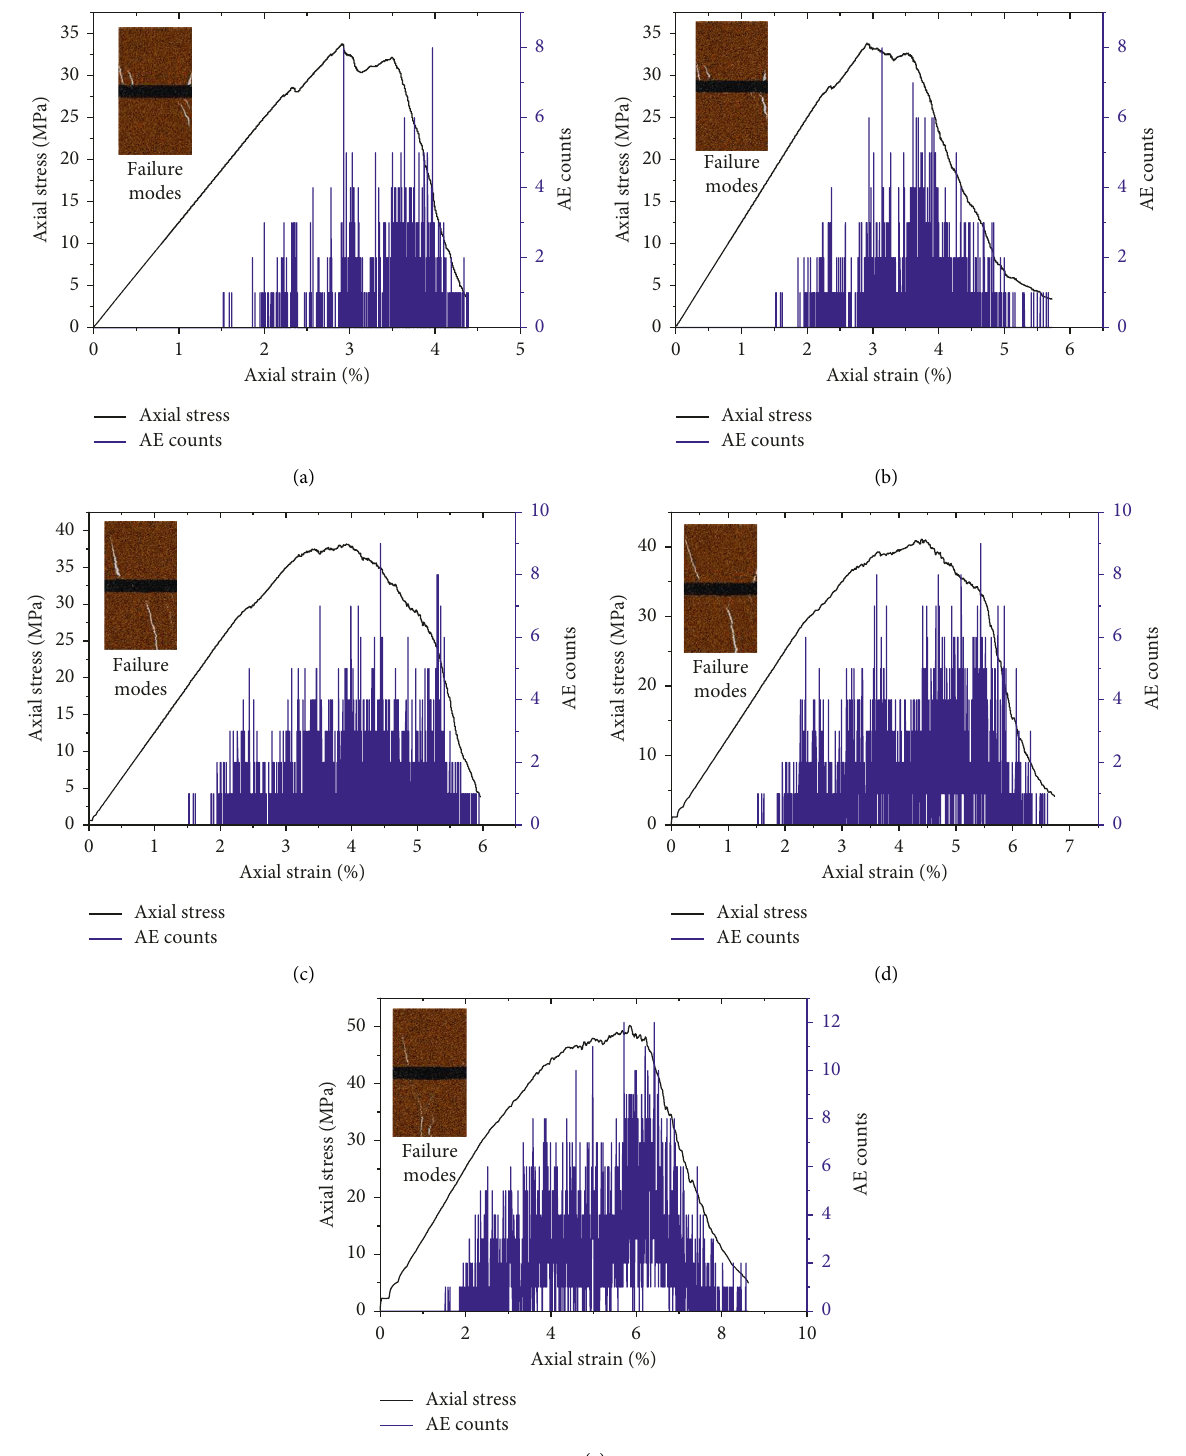
Figure 5: Stress-strain-AE count curves of the coal-rock combined sample under different loading rates. (a) 0.01mm/s. (b) 0.02mm/s. (c) 0.05mm/s. (d) 0.10mm/s. (e) 0.20